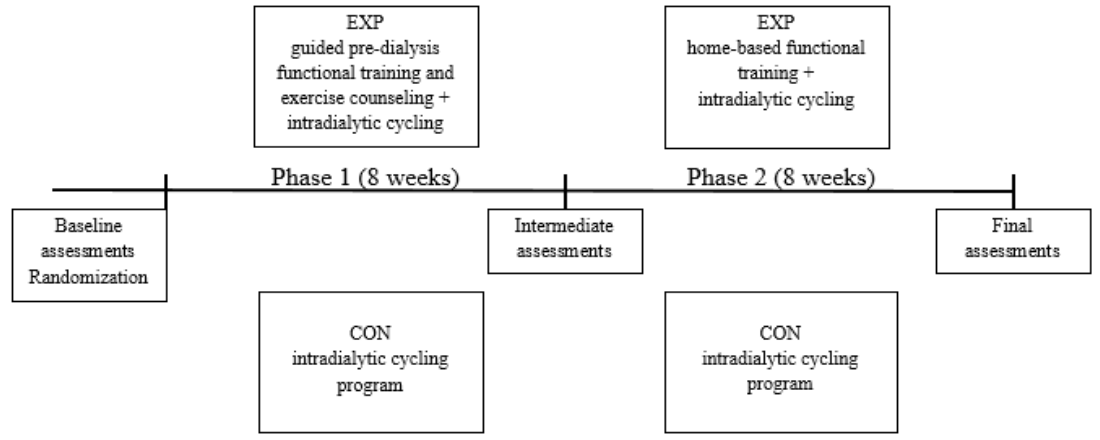
Figure 1. Study overview.Abbreviations: EXP, experimental group; CON, control group.